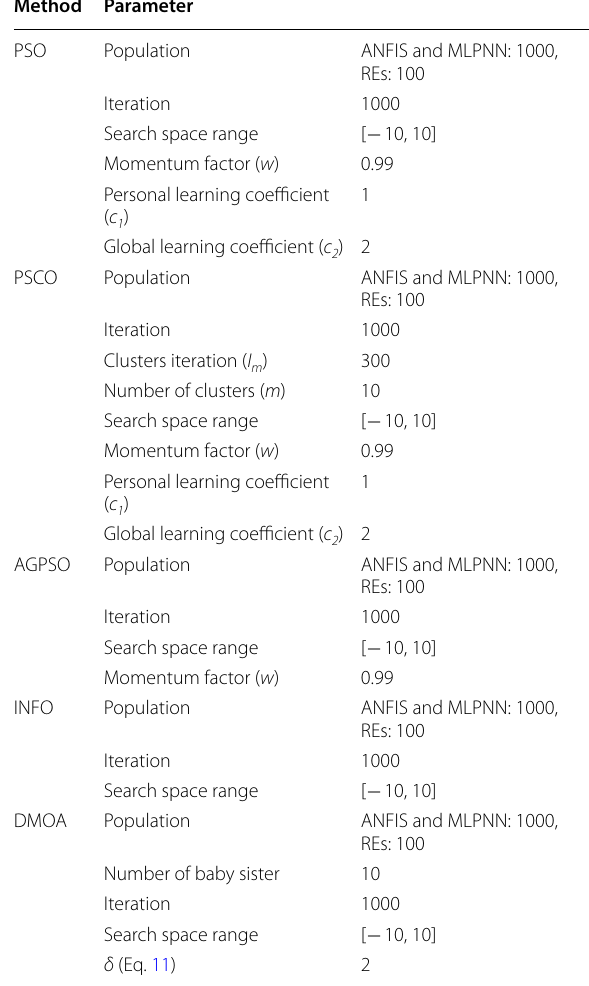
multilayer perceptron neural network (MLPNN), adap- tive neuro-fuzzy inference system (ANFIS), and regres- sion equations (REs) are integrated with particle swarm optimization (PSO), autonomous groups particles swarm optimization (AGPSO), dwarf mongoose optimization algorithm (DMOA), weighted mean of vectors (INFO), and particle swarm clustered optimization (PSCO)